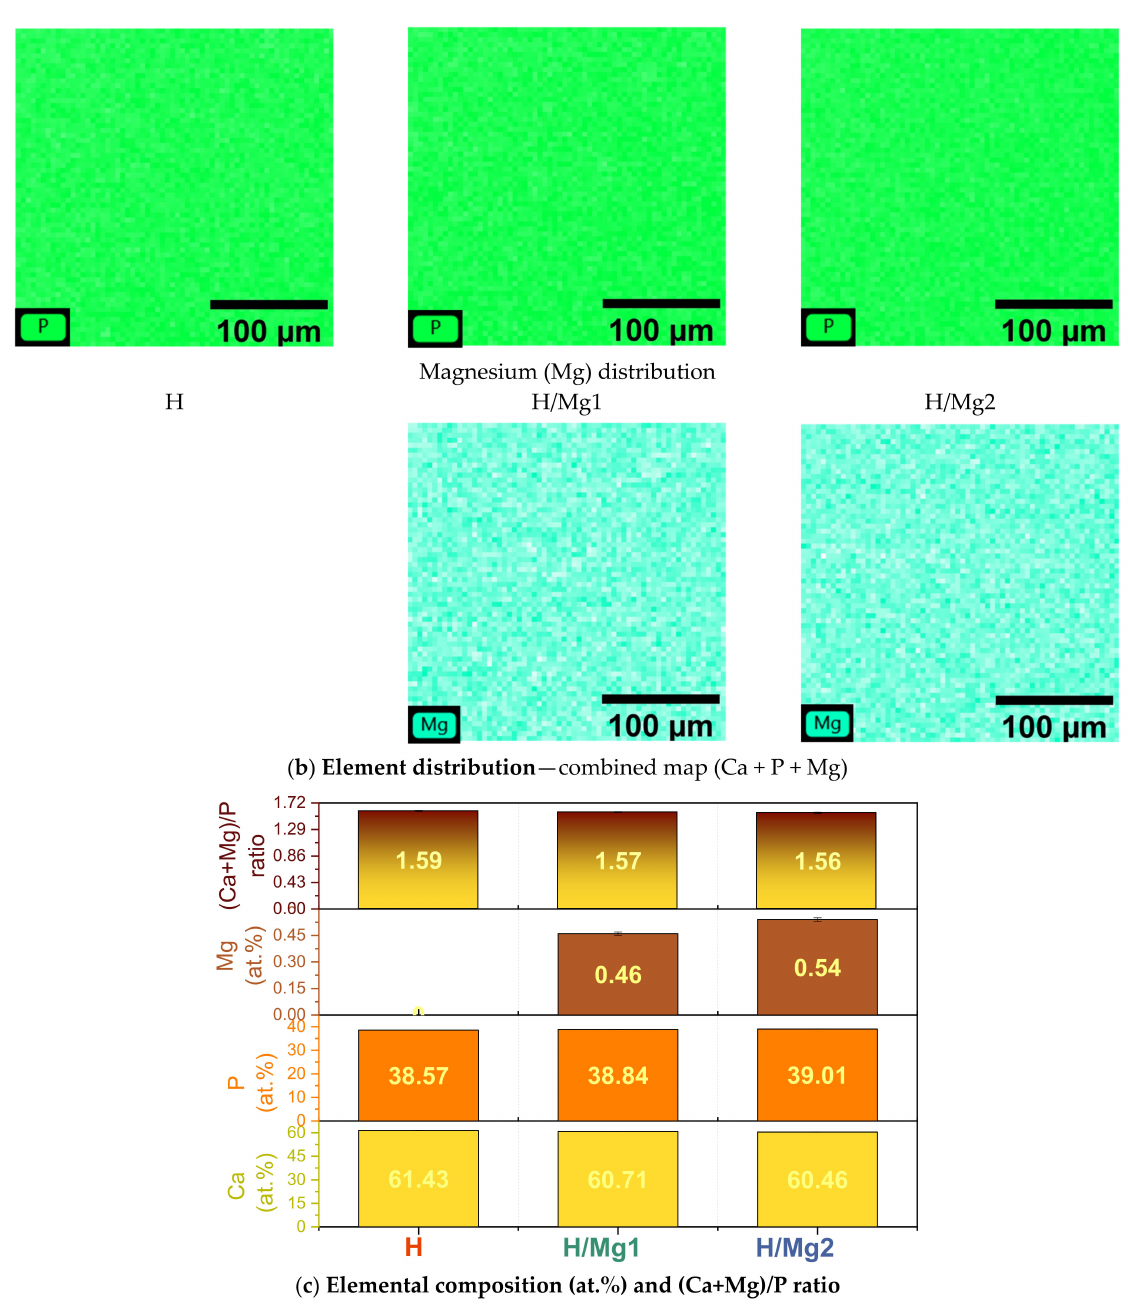
Figure 4. EDS spectra ( a ); element distribution–combined map (Ca+P+Mg) ( b ); elemental composition (at.%) and (Ca+Mg)/P ratio ( c ) of the